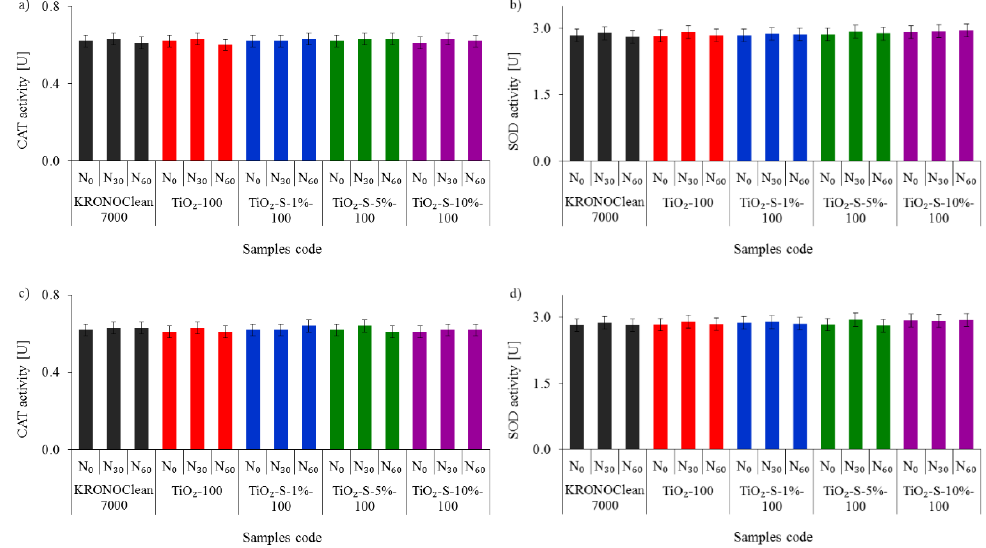
Figure 10. Influence of tested photocatalysts on the activity levels of bacterial catalase (CAT) and superoxide dismutase (SOD) in dark conditions: ( a ) CAT of E. coli ; ( b ) SOD of E. coli ; ( c ) CAT of S. epidermidis ; ( d ) SOD of S. epidermidis .